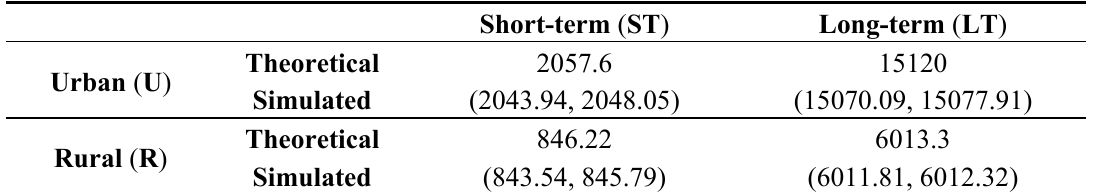
Table 12. Summary of NAN results (Goodput in bps).